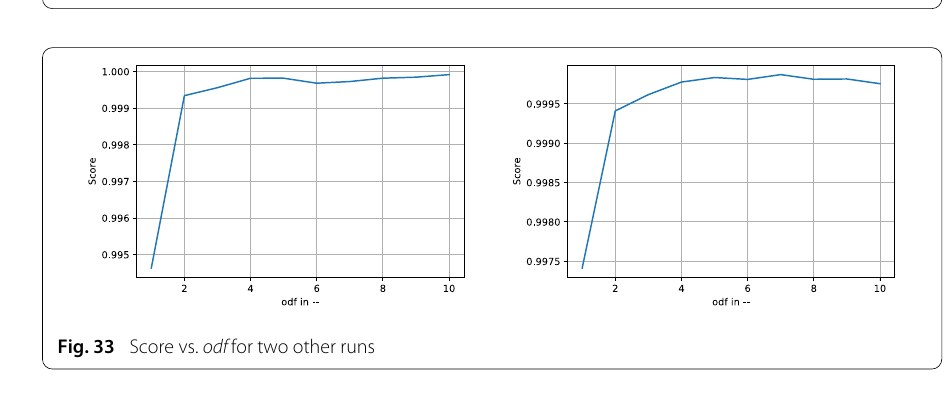
Fig. 33 Score vs. odf for two other runs